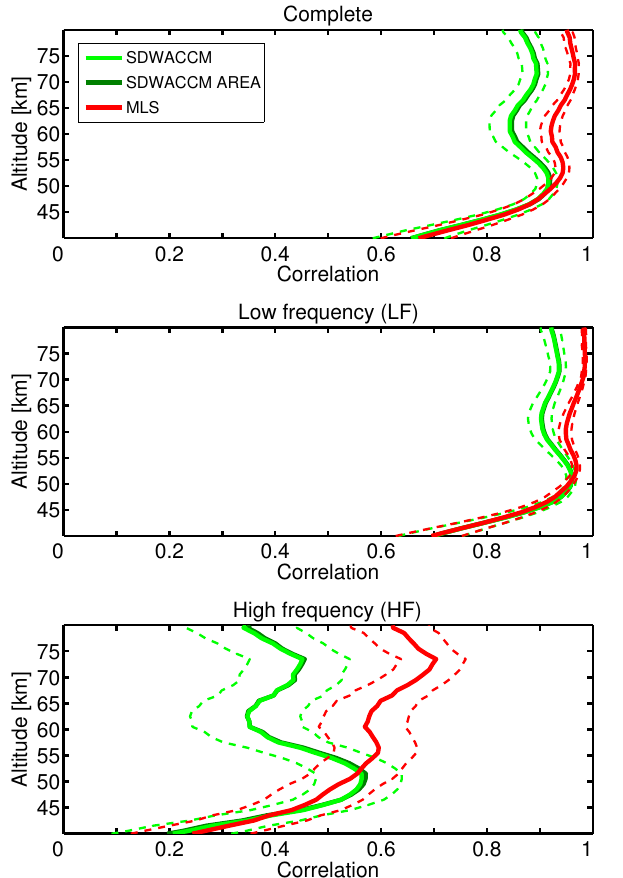
Fig. 6. Altitude profiles of the correlation coefficients of the KIMRA-SDWACCM, KIMRA-SDWACCM AREA, and KIMRA- MLS data for the complete time series (top panel), for the low fre- quency part alone (middle panel), and for the high frequency part alone (bottom panel). The dashed lines indicate the 95% confidence interval of the correlation coefficients. The KIMRA-SDWACCM AREA correlations can hardly be seen, as they are almost identical with the KIMRA-SDWACCM correlations.